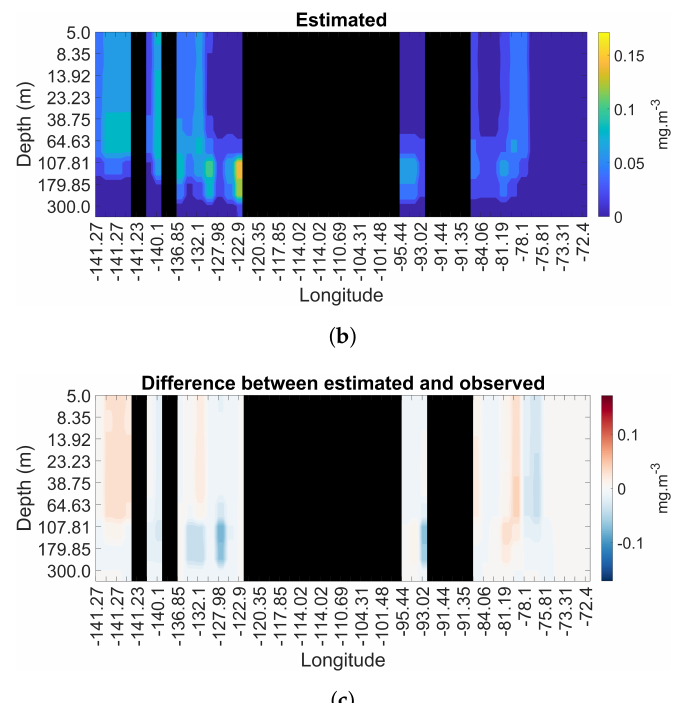
Figure 4. Result of the inversion of the DVChla profiles from the satellite data of the Biosope trajectory. ( a ) Smoothed observed DVChla profiles; ( b ) estimated DVChla profiles; ( c ) difference between estimated and observed.